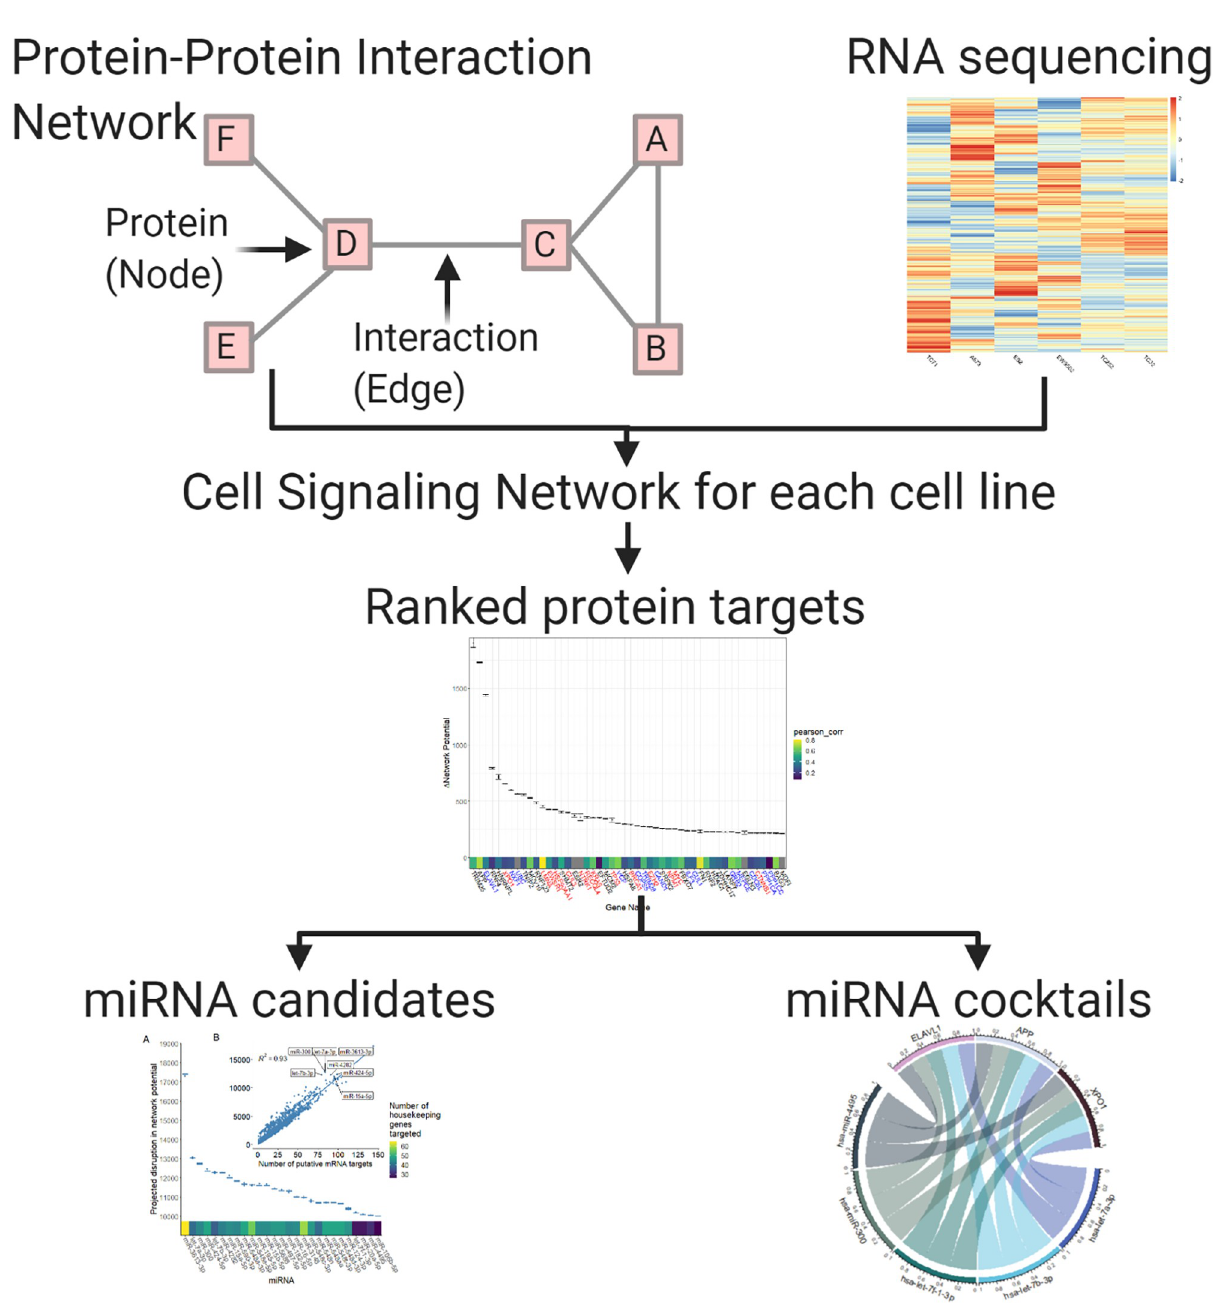
Fig 2. Simplified schematic of our computational pipeline. We defined a measure of tumor state, which we term network potential (Eq 1), based on both mRNA gene expression and the underlying protein-protein interaction (PPI) network. Next, we ranked mRNA targets based on their contribution to network potential of each cell line, aiming to approximate the relative importance of each mRNA to network stability. After identifying these mRNA targets, we then identified miRNA and miRNA cocktails that preferentially acted to repress the most influential of the ranked mRNA targets, with the aim of defining synthetic miRNA-based therapy for down-regulation of these